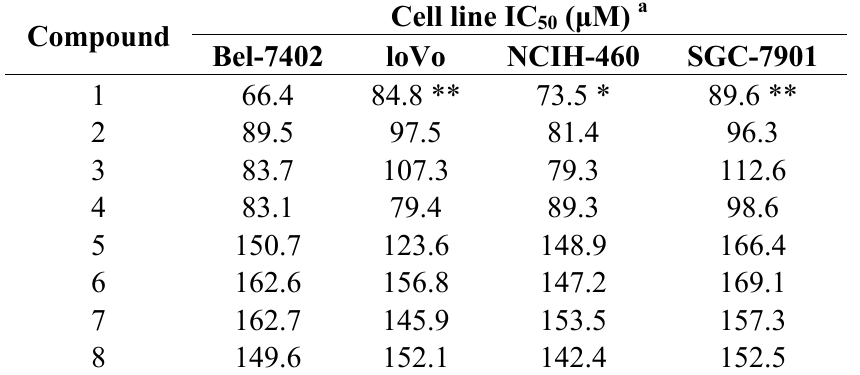
Table 1. Cell growth inhibitory activities of eight triterpenoids in Bel-7402 cells, loVo cells, NCIH-460 cells and SGC-7901